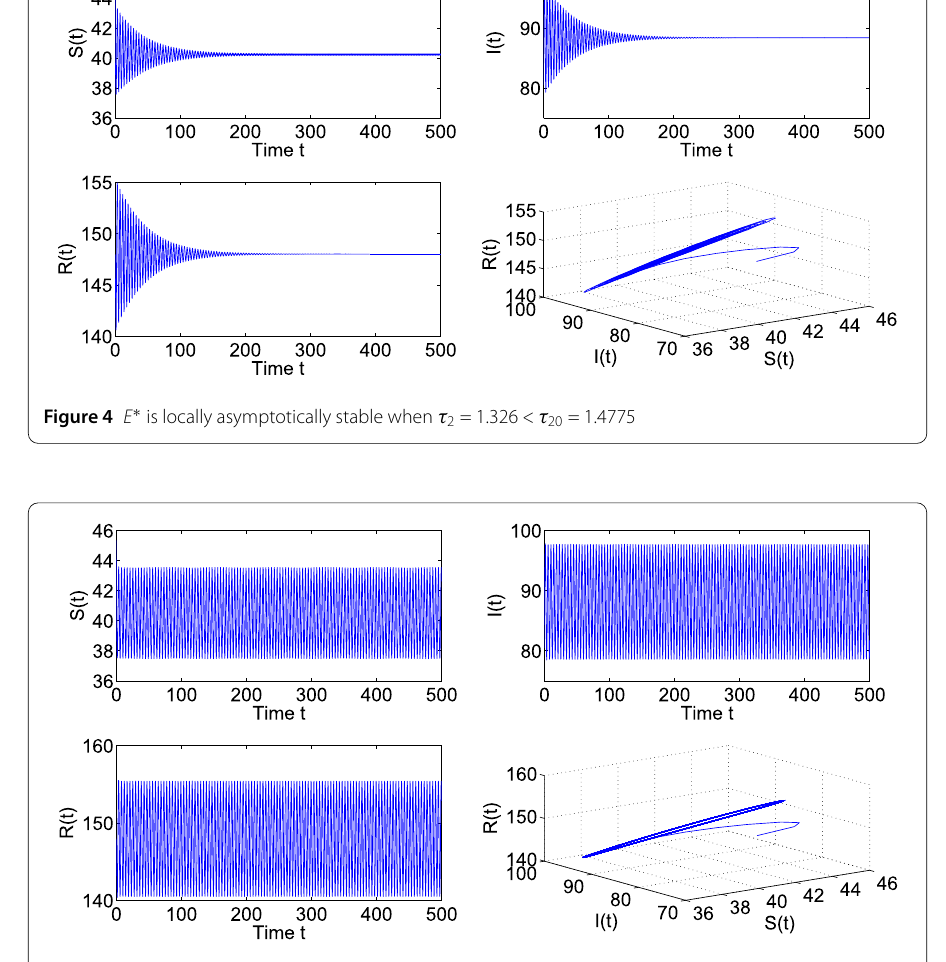
Figure 5 System (45) under goes a Hopf bifurcation when τ 2 = 1.518 > τ 20 =